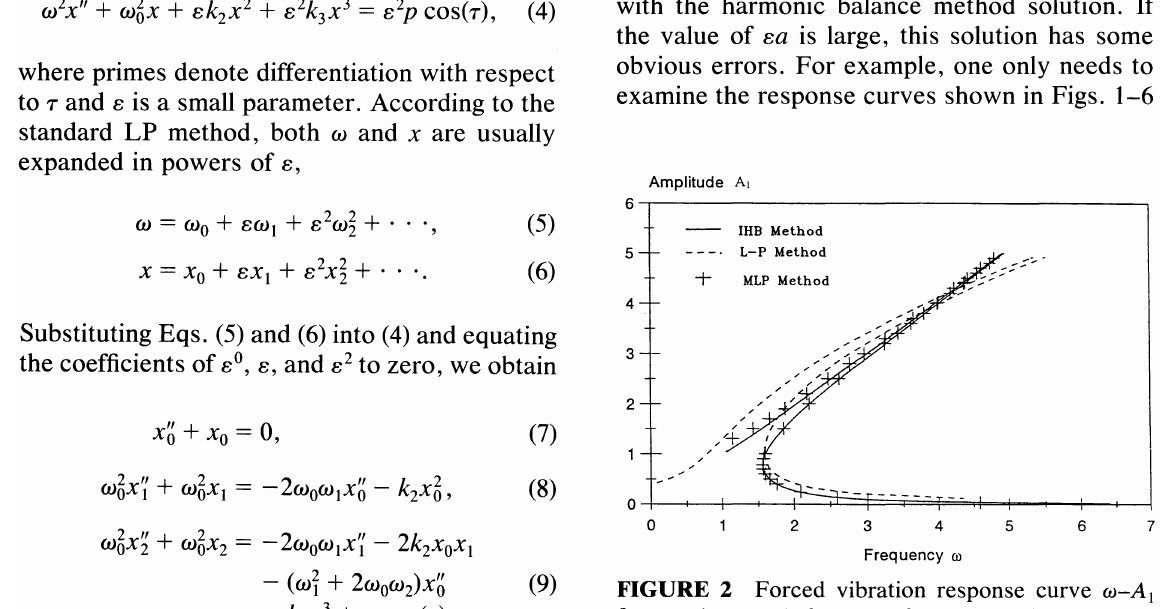
Xo and WI , XI and W2, and X2 can be solved sequen tially. Finally the solution is expressed as